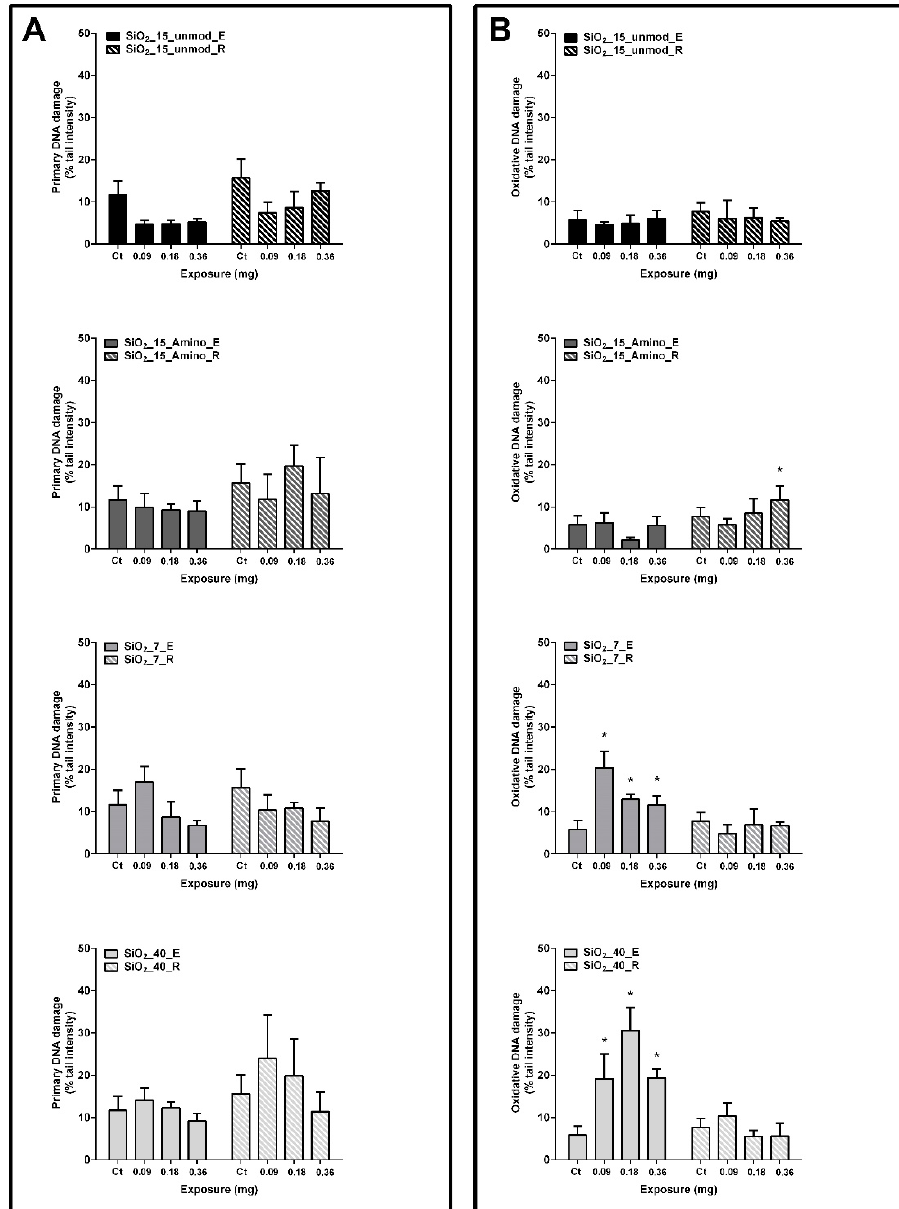
Figure 2. Primary ( A ) and oxidative ( B ) DNA damage in the rat lung tissue after 3 days (exposure group; E) and 21 days (recovery group; R) of a single intratracheal instillation (0.09–36 mg) of different variants of aSiO 2 NM (SiO 2 _15_Unmod, SiO 2 _15_Amino, SiO 2 _7 and SiO 2 _40), as assessed by the comet assay. Percentage of DNA in the tail (% tail intensity) was used as DNA damage descriptor. Columns represent mean and error bars are the standard deviation (SD); Ct (negative control). * p < 0.05 vs.